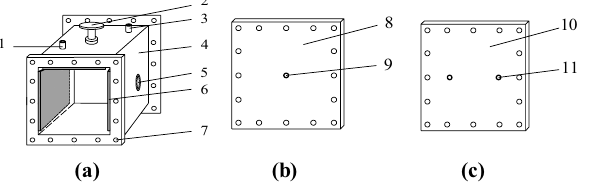
Figure 3. An experimental device used for blasting simulations: ( a ) main body of the box, ( b ) front cover plate, and ( c ) rear cover plate.